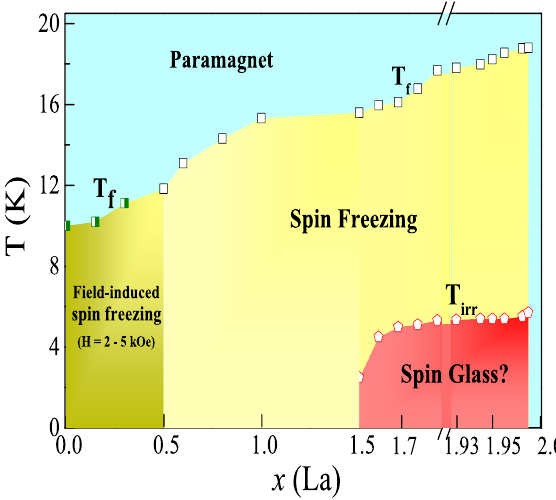
Figure 6. Magnetic phase diagram of Dy 2 − x La x Zr 2 O 7 ; x = 0–2.0 showing the evolution of spin freezing transition on La substitution. Data points marked by star are taken from Ref[16] indicating the field induced spin ice phase for x ≤ 0.5. The compositions between 0.5 < x ≤ 1.99 represents the spin freezing transition ( T f ) and the low temperature state culminates to glassy behavior marked by T irr